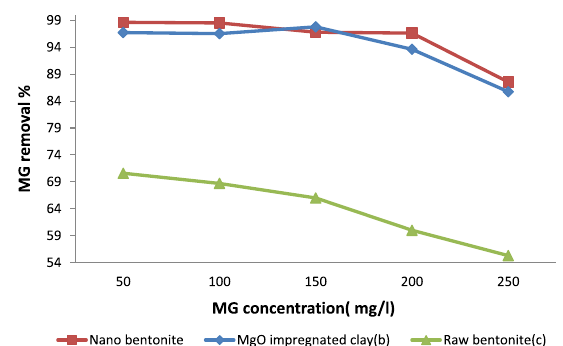
Fig. 9 Effect of initial MG dye concentration on MG dye removal by a nano-bentonite, b MgO impregnated clay and c raw bentonite